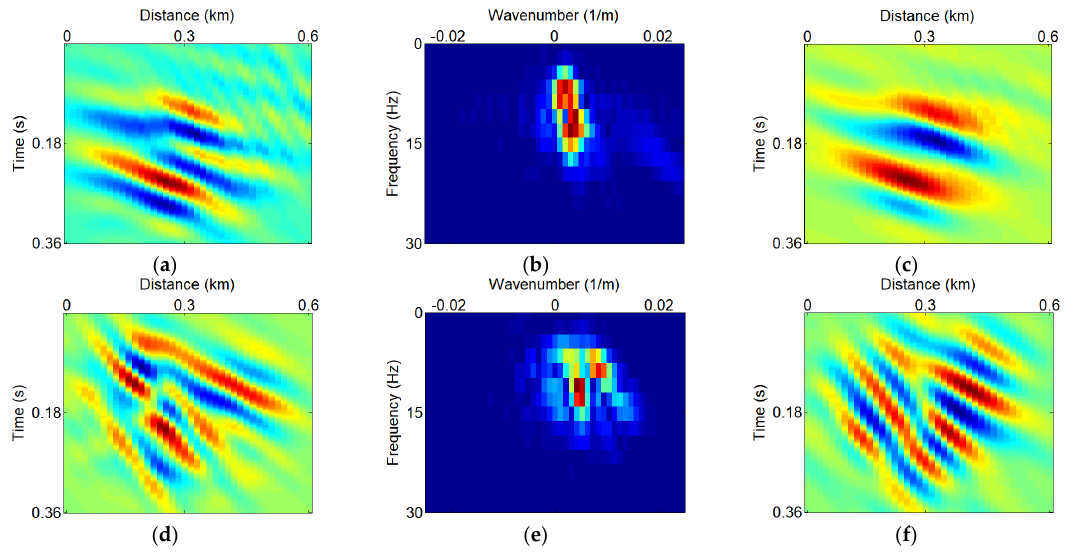
Figure 2. Windowed seismic data in the time-space domain and frequency-wavenumber domain; ( a , c ) are extracted from the red and blue rectangular boxes of Figure 1, respectively; ( b , e ) are the frequency-wavenumber domain amplitude information of ( a , d ), respectively; ( c , f ) are the phase-corrected seismic data of ( a , d ) with ε = 0.5,